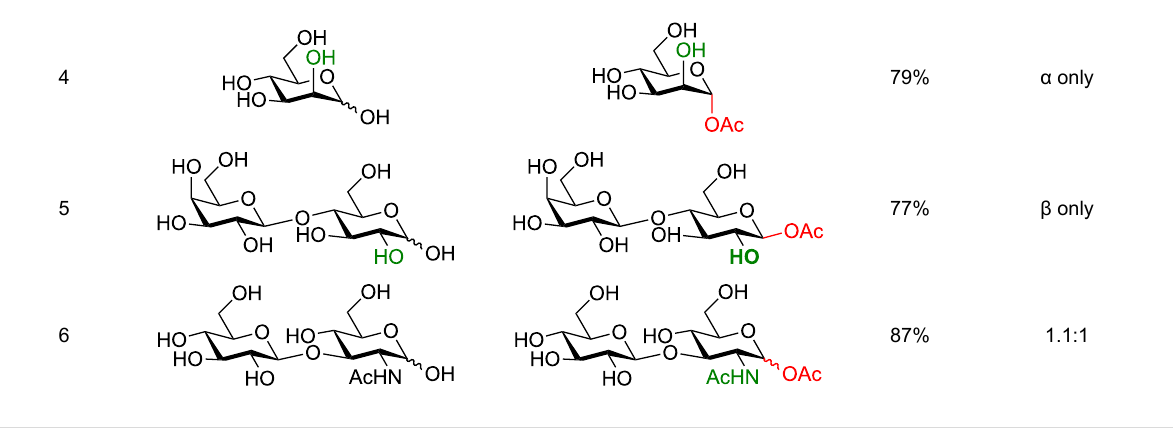
Table 6: Protecting group-free acetylation of unprotected carbohydrates via activation with DMC.